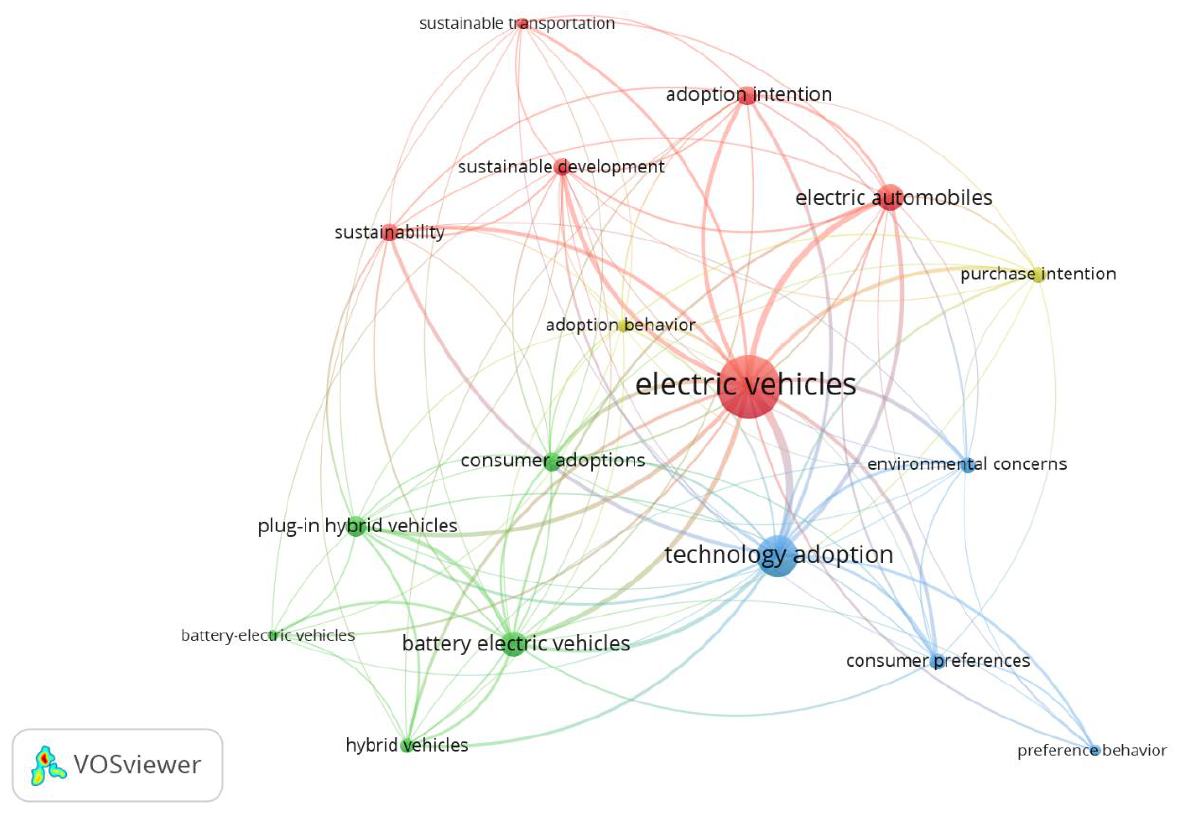
Figure 4. Co-occurrence of keyword distribution in the reviewed articles.